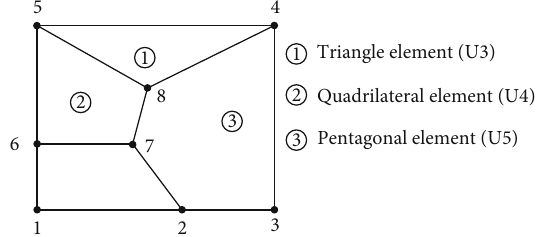
Figure 3: Schematic diagram of the polygon meshes. 1 ∗ USER ELEMENT, NODES=5, TYPE=U5, PROPER- TIES=2, COORDINATES=2 2 8 3 ∗ ELEMENT, TYPE=U5, ELSET=E5 4 3,2,3,4,8,7 5 ∗ UEL PROPERTY, ELEST=E5 6